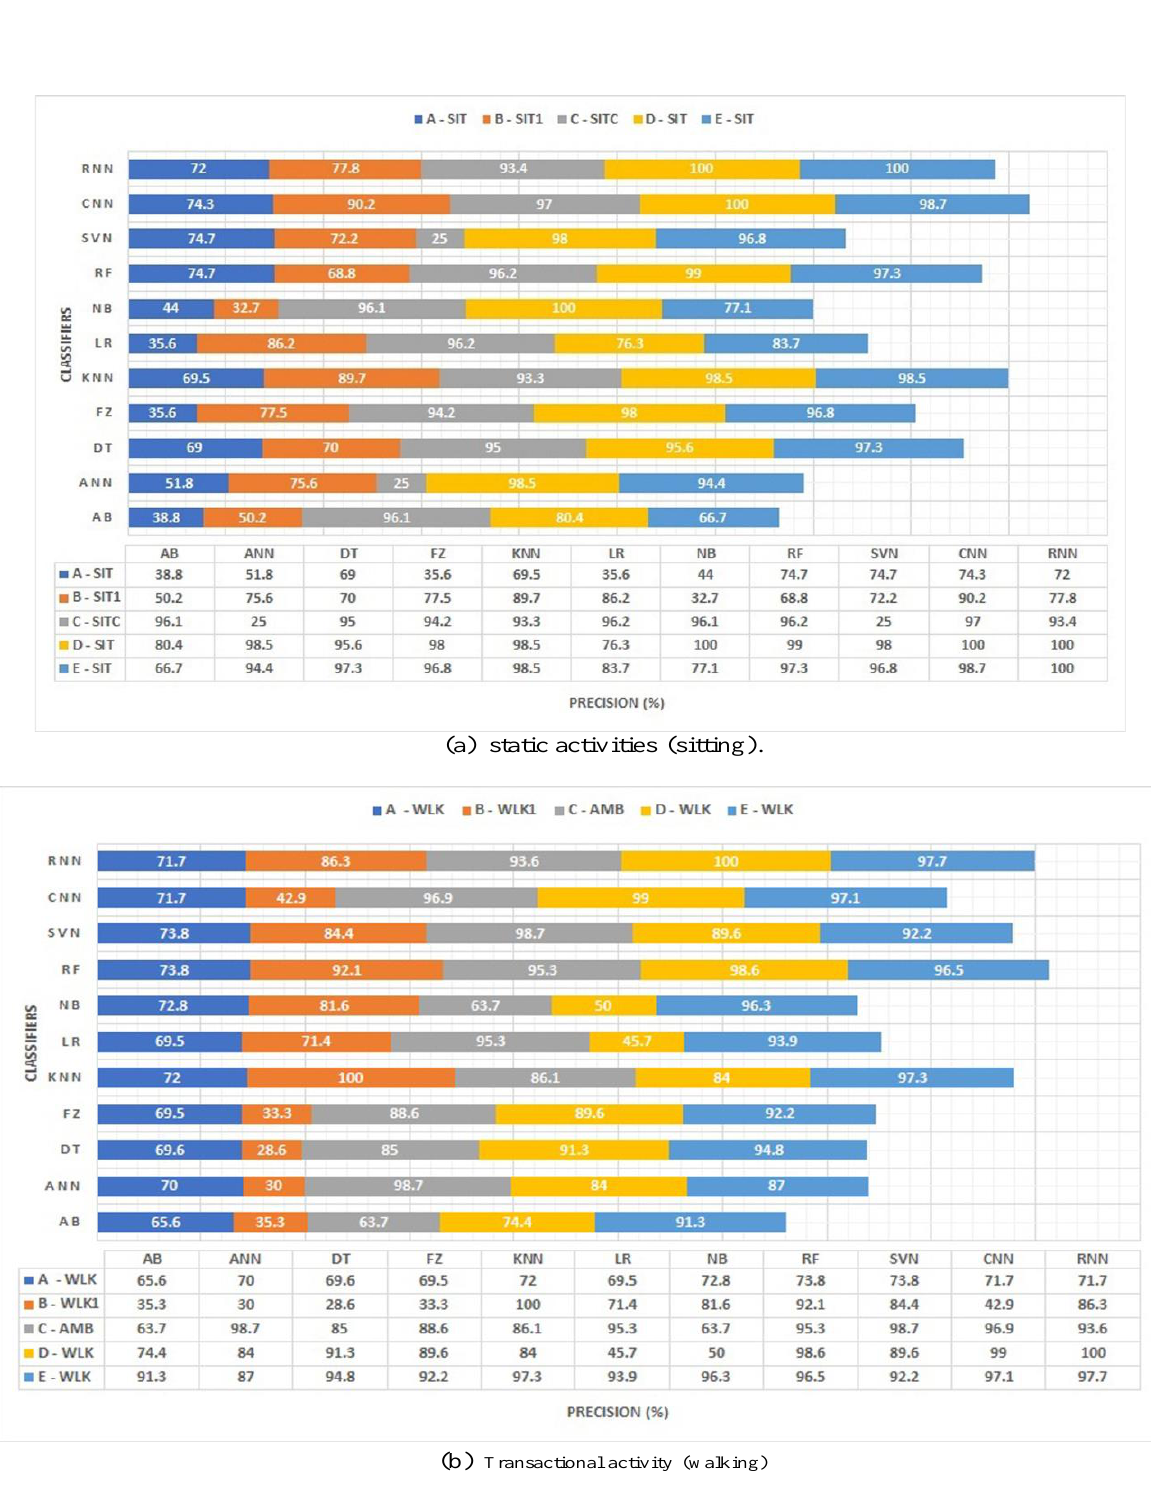
Figure 4. Precision comparison analysis for static activity (sitting) and transactional activity (walking) of all classifiers. One activity from each dataset can be seen. Each activity is represented as <Dataset Representation >- <Activity abbreviation denoted in table 2 >. A represents AReM dataset, B represents HAPT dataset, OLDPPL is represented by C, D represents PAMAP2 dataset and E represents WISDM